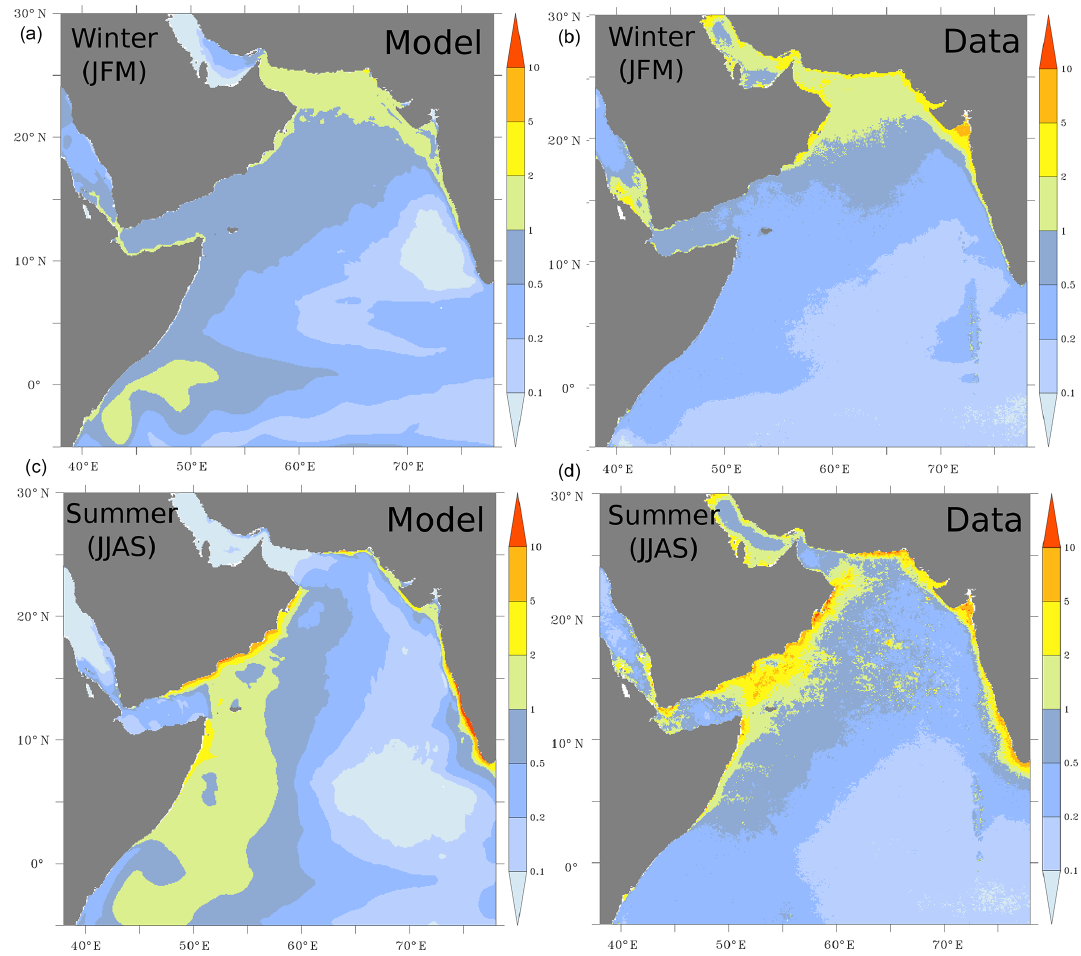
Figure 2. Surface distribution of chlorophyll a . Surface chlorophyll- a concentrations (in mgm − 3 ) as simulated in ROMS (a, c) and from SeaWiFS (b, d) during winter (a, b) and summer (c, d) months. The SeaWiFS climatology is computed over the period from 1997 to